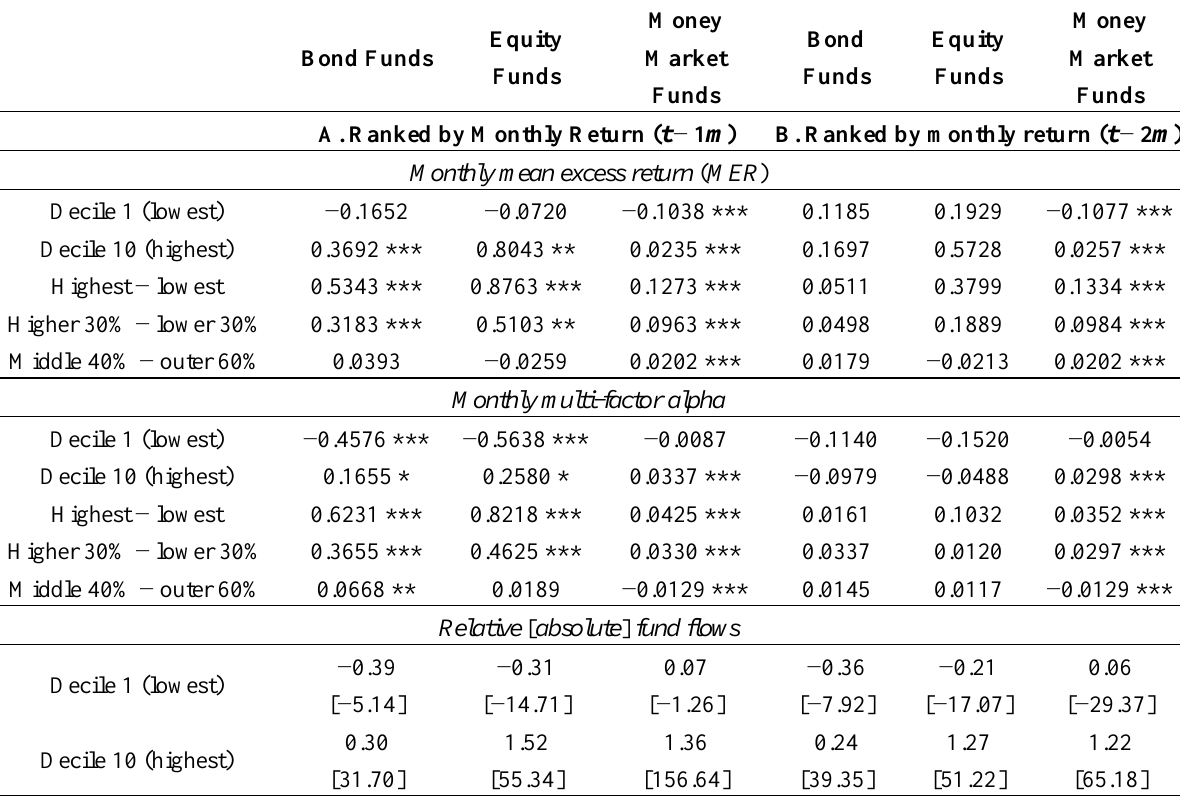
Table 5. Performance of deciles ranked by lagged